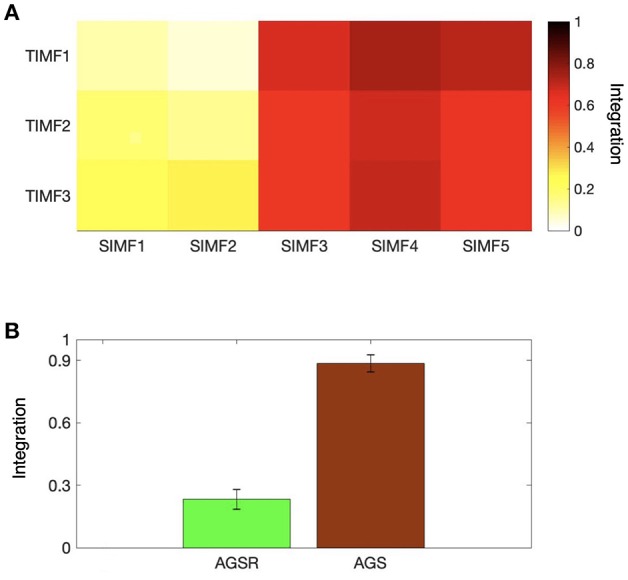
Integration of the brain network at different spatiotemporal scales. (A) Average efficiency of the whole brain network for different spatial and temporal IMFs defined in functional connectivity. (B) Comparing the magnitude of average efficiency of the brain network over all subjects when the AGS is removed from the fMRI time series (the sum of SIMF3 to SIMF5 in all TIMFS are removed and the sum of SIMF1 to SIMF2 including all TIMFs of the fMRI signal are considered to compute the connectivity), and the average efficiency of the AGS (summing up SIMF3 to SIMF5 in all TIMFs). High efficiency values in the SIMF3 to SIMF5 which represent the AGS in the fMRI data are seen in the figures. GS, Global Signal; AGS, Adaptive GS.